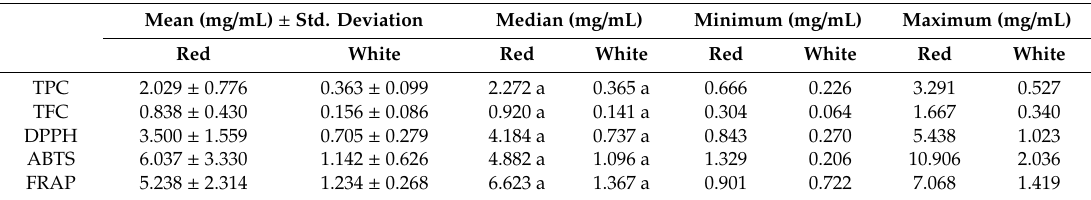
Table 4. Total phenolic and flavonoid concentrations as well as antioxidant capacity in wines by amateur winemakers of Drama region in Greece